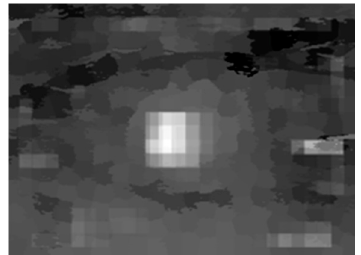
Figure 8. Combined saliency map.